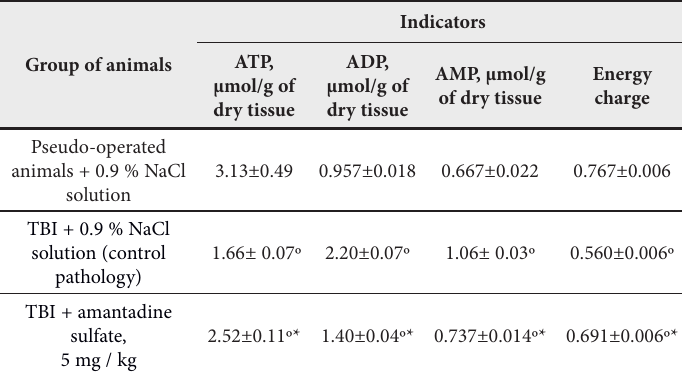
Effect of a 8-day course infusion of amantadine sulfate on the content of adenyl nucleotides in the brain of rats with traumatic brain